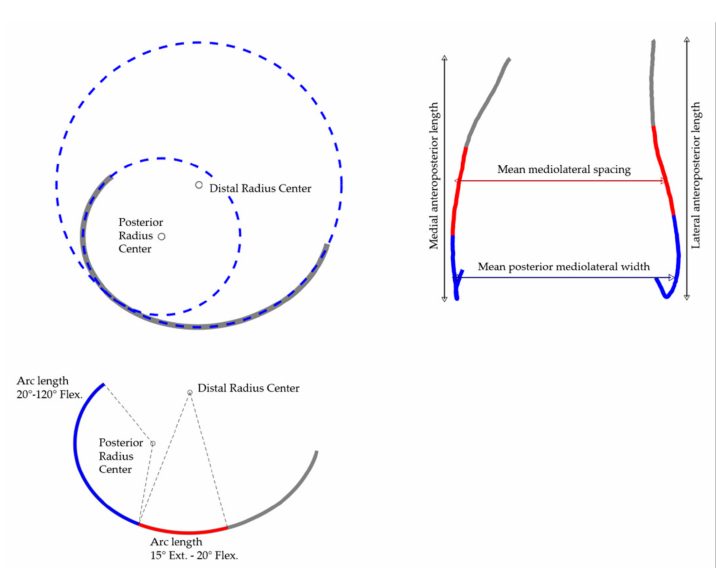
Figure 2. Visualization of the geometric parameter analysis on the example of the mean shape (combined